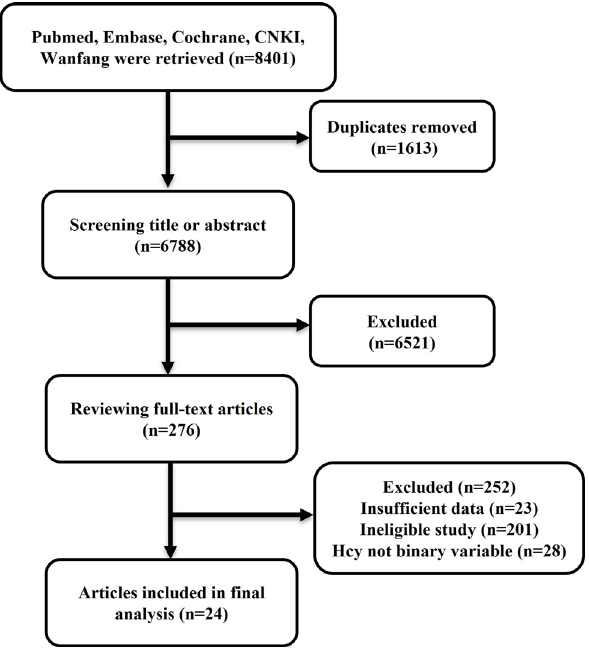
Figure 1: Publication electronic searching fl ow chart demonstrate that 24 studies were fi nally included for meta -